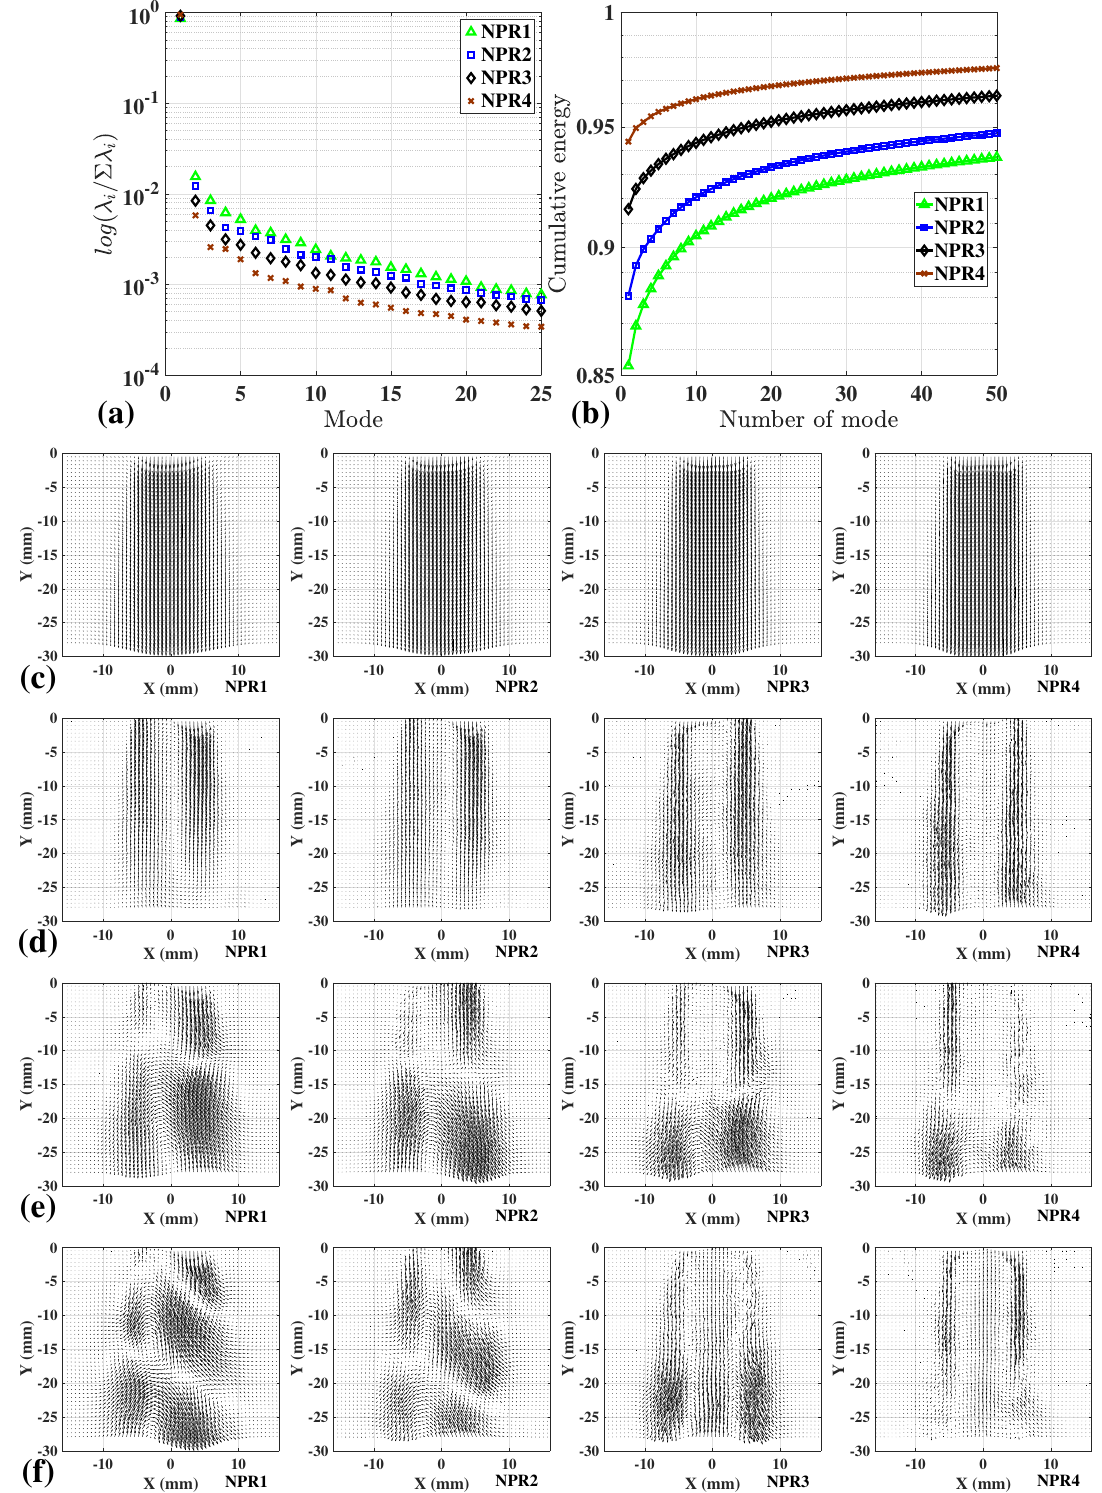
Figure 10. POD analysis of the velocity fields obtained from the 2D2C PIV measurements of under-expanded free jets for NPR 1 = 2, NPR 2 = 2.2, NPR 3 = 2.5, and NPR 4 = 2.77. ( a ) Kinetic energy spectra; ( b ) cumulative energy. Low-order POD velocity modes ( c ) Ψ 1 , ( d ) Ψ 2 , ( e ) Ψ 3 , and ( f ) Ψ 4 . Vectors were de-sampled for better